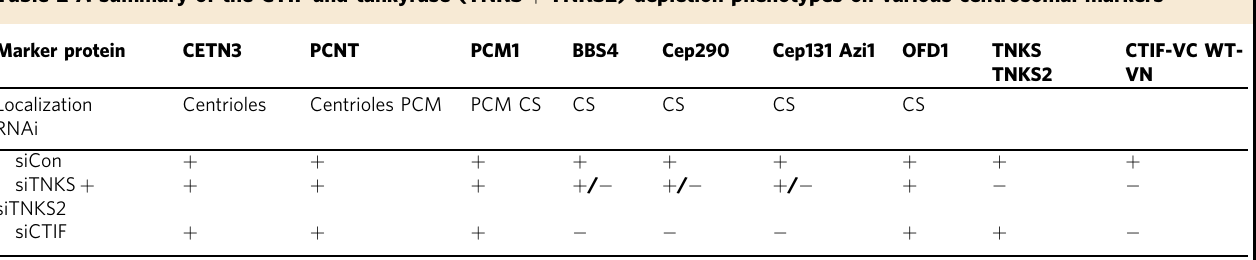
Table 2 A summary of the CTIF and tankyrase (TNKS + TNKS2) depletion phenotypes on various centrosomal markers